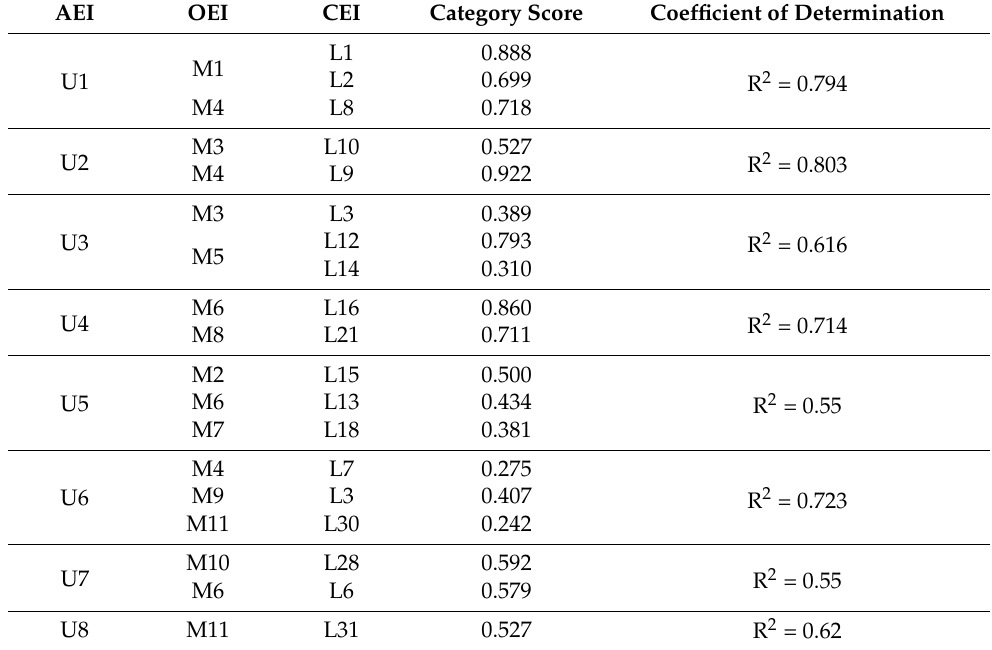
Table 8. The analysis results from